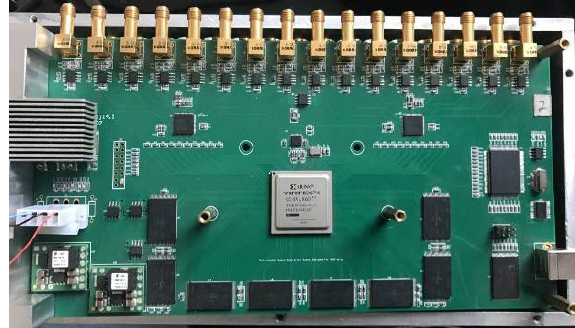
Figure 4. Ultrasonic transmitting/receiving acquisition circuit.